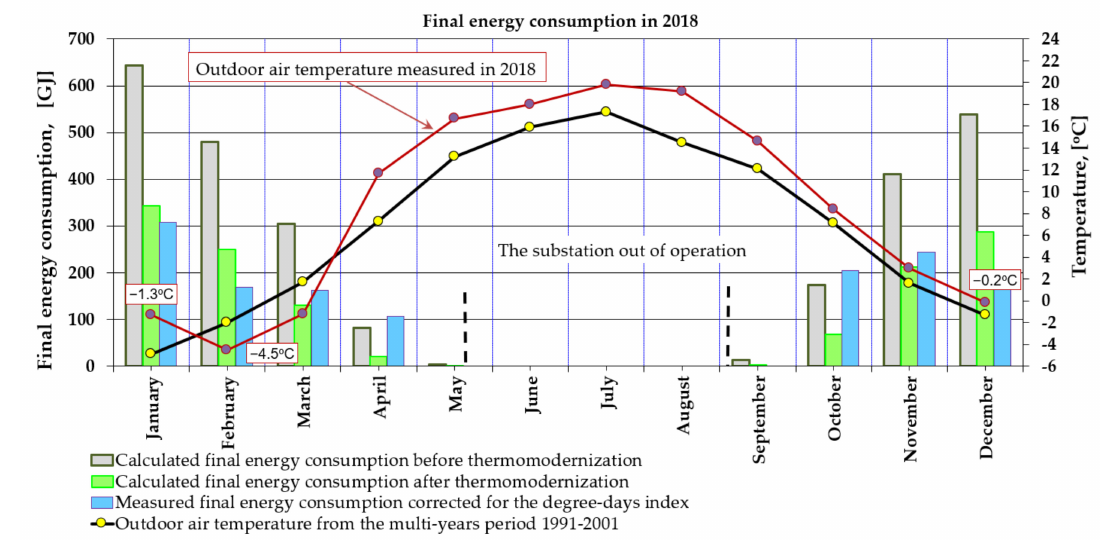
Figure 12. Final heat energy consumed for heating and ventilation needs of building A in 2018 and final energy corrected by the energy index of degree days ∂ together with the monthly outdoor air temperatures recorded in 2018 and the average outdoor air temperature for the multi-year period for the Bialystok weather station.